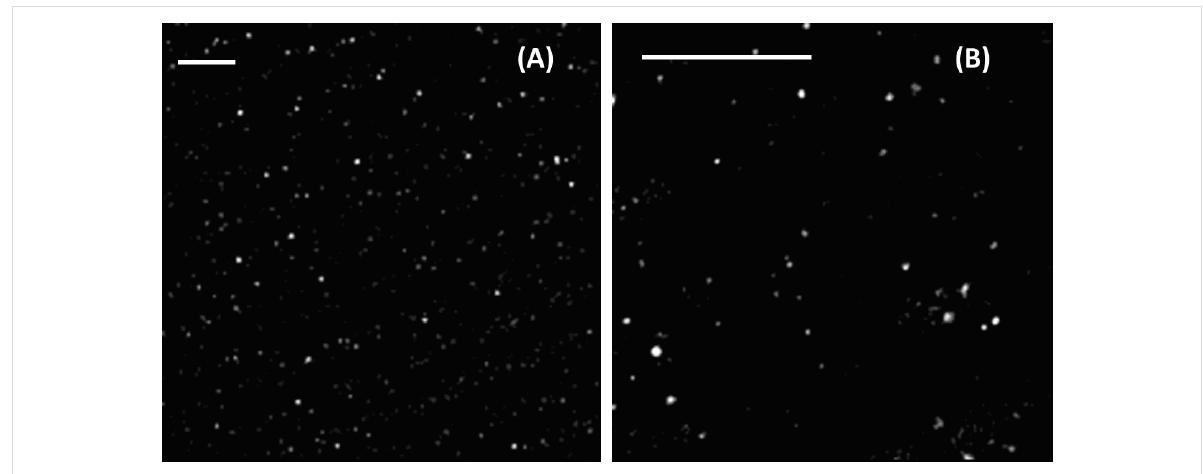
Figure 2: The confocal reflection images of PVA films containing gold nanostars. Field of view = 77.2 × 77.2 μ m (panel A); field of view = 25.8 × 25.8 μ m (panel B). Z-resolution ≈ 1.2 μ m. The white scale bars indicate 10 μ m.